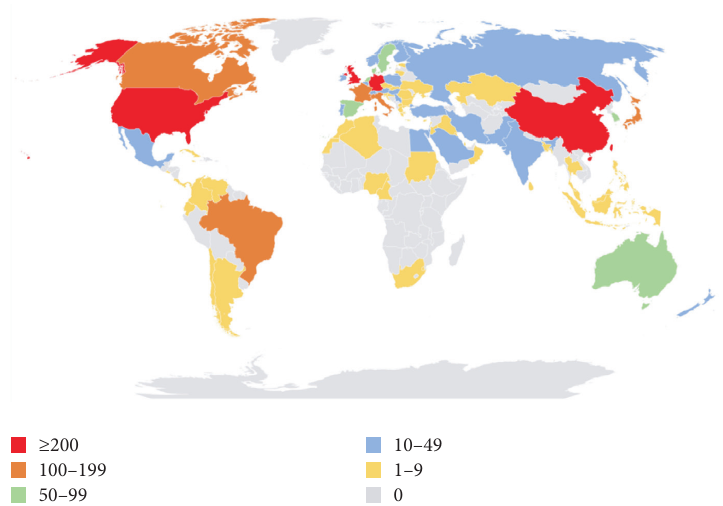
Figure 8: World map of total country output based on pain and inflammation research.